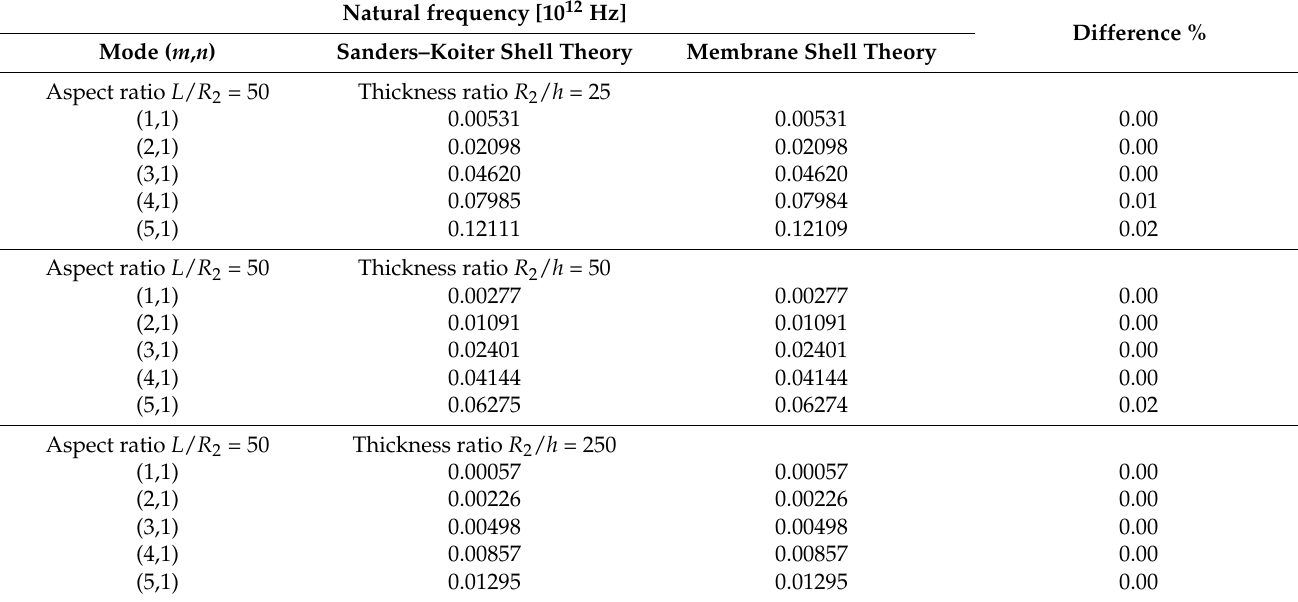
Table 10. Simply supported DWCNT with aspect ratio L / R 2 = 50 and thickness ratios R 2 / h = (25,50,250). Beam-like modes ( n = 1). Comparisons between Sanders–Koiter and membrane shell theories.